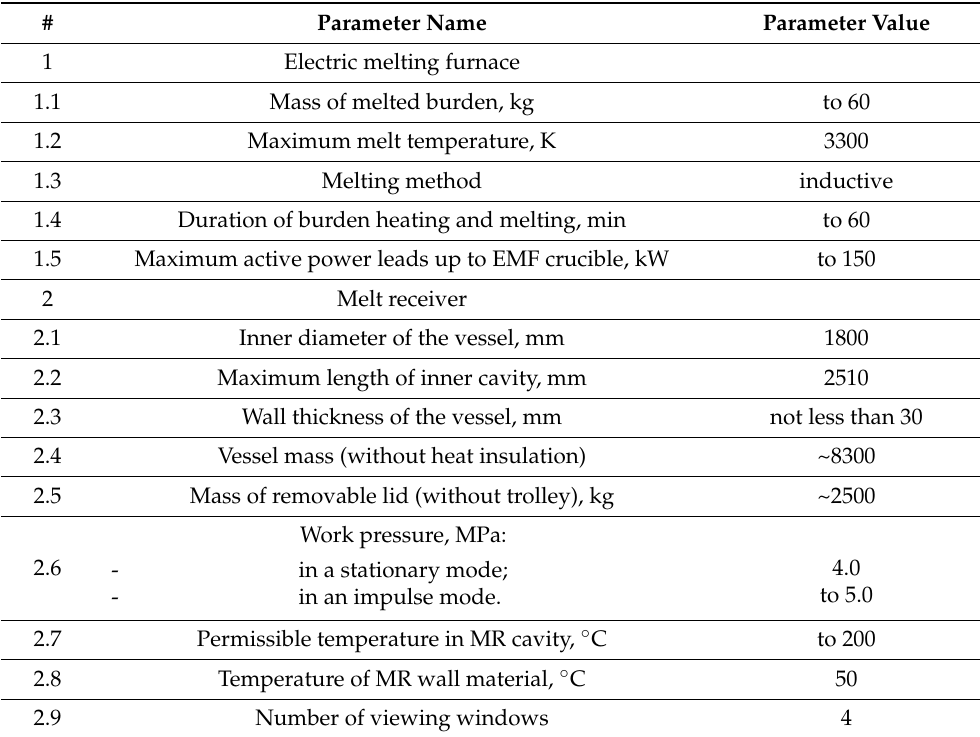
Figure 1. LAVA-B installation. Table 1. Main characteristics of the “LAVA-B” installation.